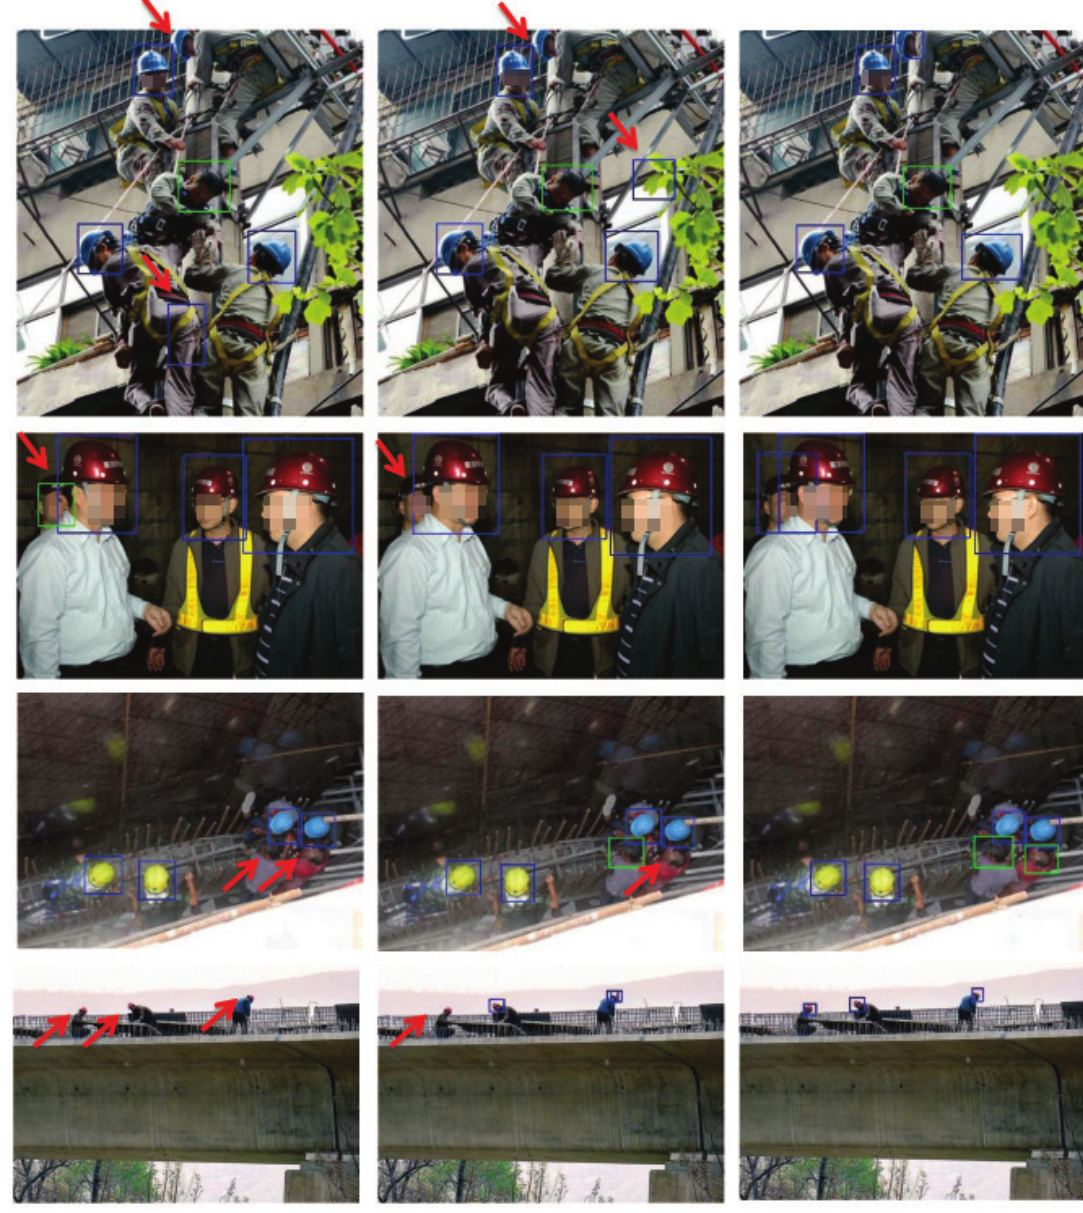
Figure 3. Examples of the detection results using different network architectures. Left: baseline; Middle: baseline + top-down; Right: proposed. Persons indicated by red arrows correspond to incorrect